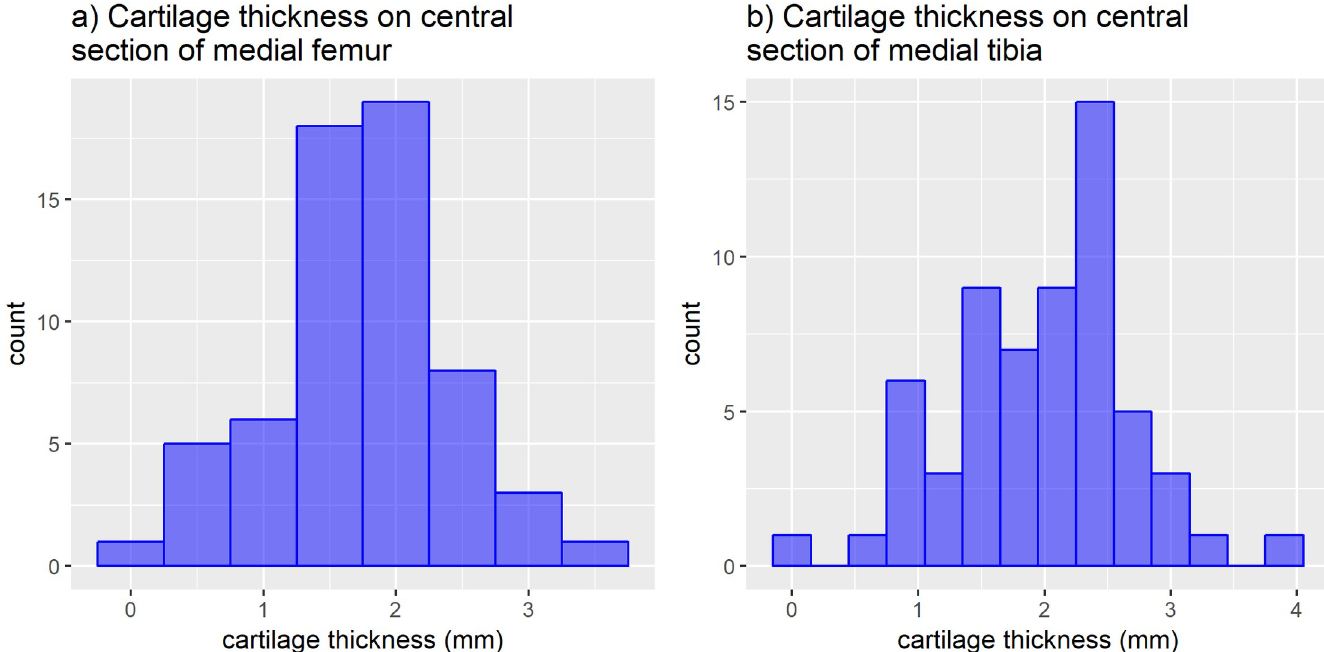
Fig 2. Distribution of cartilage thickness (n = 29). a) Thickness of cartilage on the central medial femoral condyle (anterior aspect) over total area of subchondral bone representing subchondral bone area. Peripheral osteophytes are excluded, base of central osteophytes are included. b) Thickness of cartilage on the central medial tibia over total area of subchondral bone representing premorbid subchondral bone area. Peripheral osteophytes are excluded, base of central osteophytes are included.